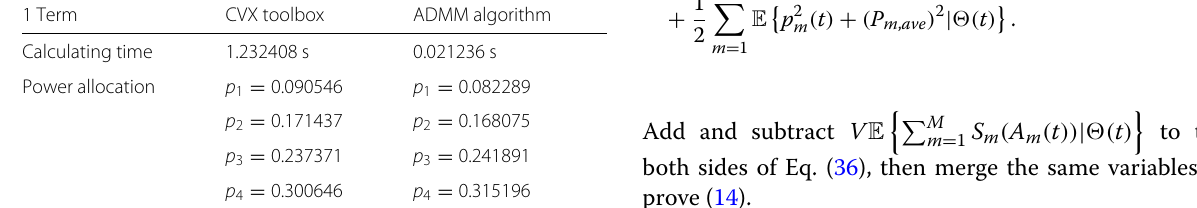
1 Term CVX toolbox ADMM